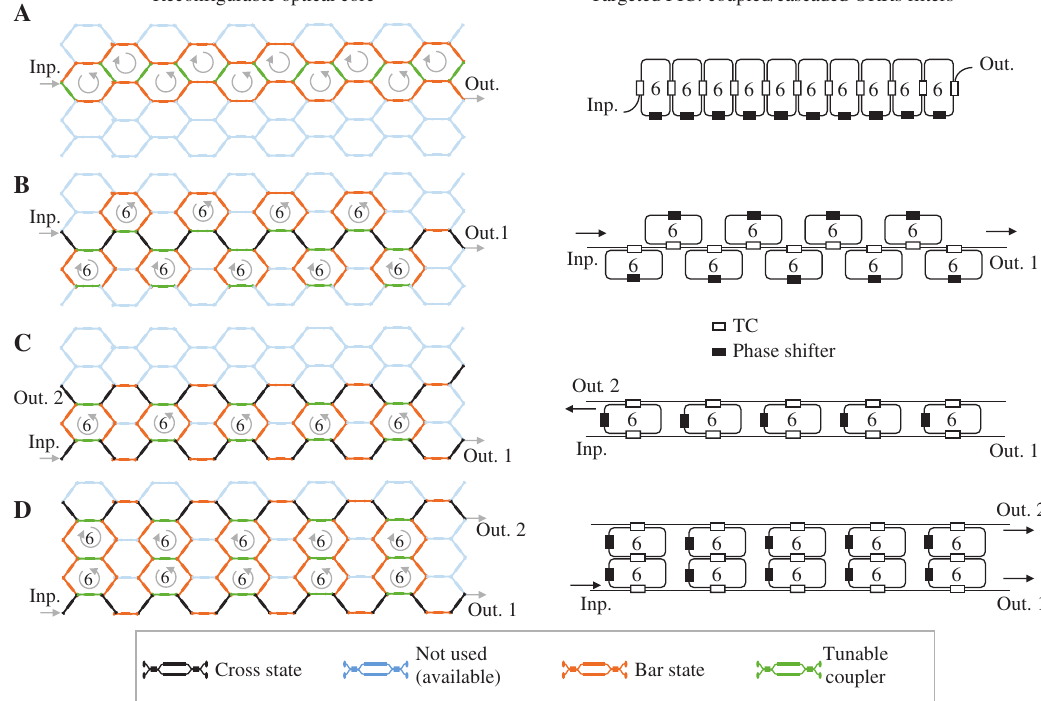
Figure 5: Different examples of programming different single input-single outtput and 2 × 2 circuits using the same waveguide mesh and resulting circuit layouts. (Left) Settings for CROW and SCISSOR filter implementations in the hexagonal mesh core for (right) (A) 10th-order CROW, (B) 9th-order single channel SCISSOR, (C) 5th-order double channel SCISSOR and (D) twisted double channel SCISSOR. 6-BUL cavities are